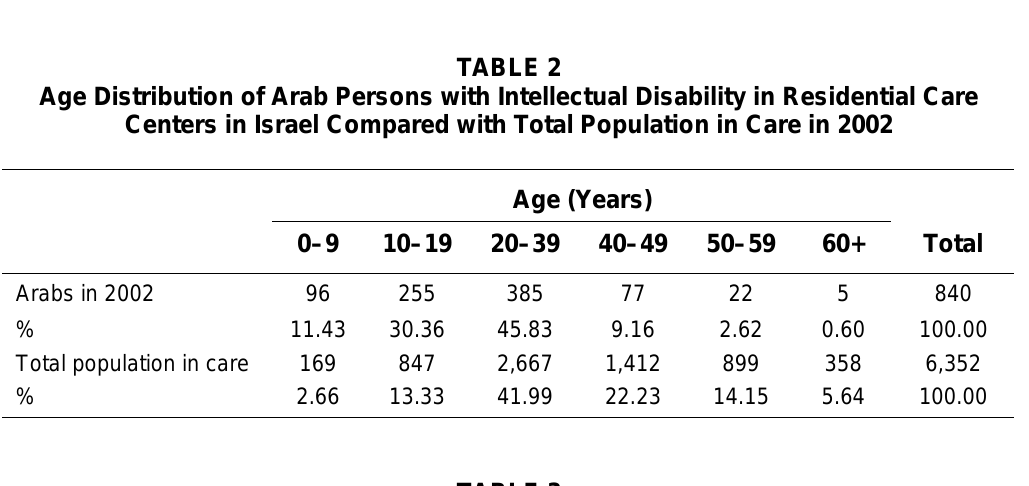
Level of Intellectual Disability of Arab Persons with Intellectual Disability in Residential Care Centers in Israel Compared with Total Population in Care in 2002